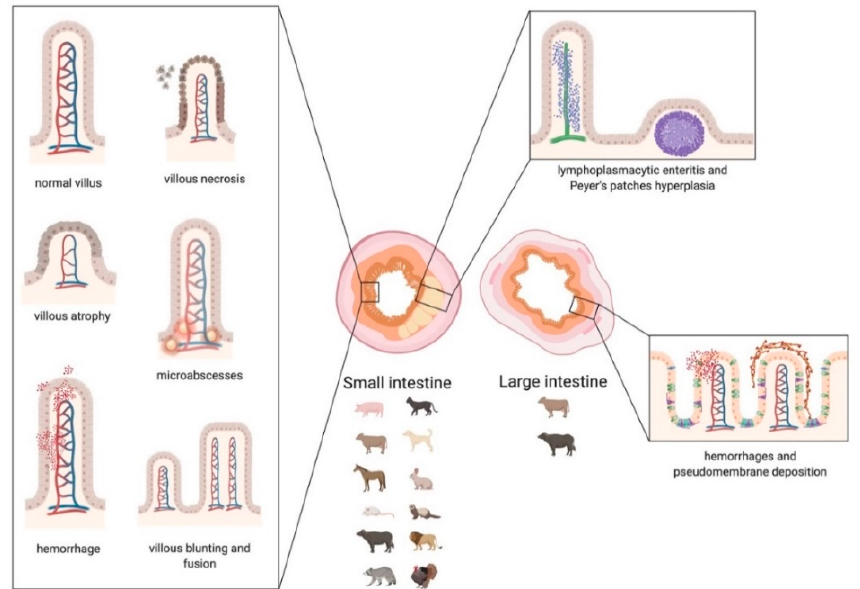
Scheme 3. Graphic representation of the main respiratory lesions associated with Coronavirus infections in animals. A ff ected upper (top box) and lower (bottom box) respiratory tract: the healthy tissue is represented on the left side of the boxes and the lesions on the right side. The species mainly a ff ected by respiratory lesions are represented on the lower left corner. Lesions of the upper airways are mainly characterized by mucosal inflammation consisting of neutrophilic (or heterophilic) and lymphocytic infiltrate, sloughing of epithelial cells, loss of cilia, epithelial cell hyperplasia, and hypertrophy of mucosal glands. Lesions in the lungs are mainly characterized by hemorrhages with neutrophilic (or heterophilic) and lymphocytic infiltrate, severe edema, epithelial cell detachment, and fibrinous exudate. The scheme has been created with